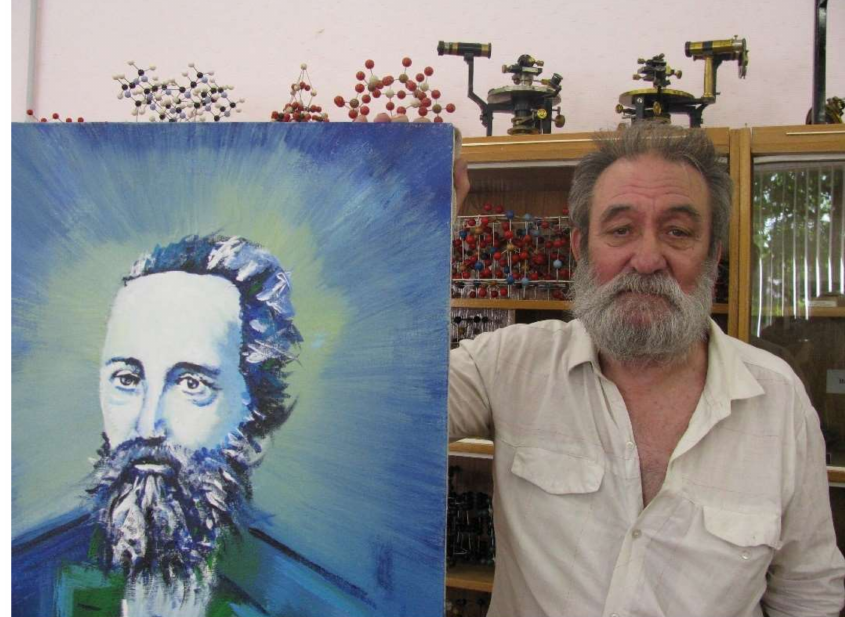
Figure 2. Vadim ˙El’eviˇc Cubin (Fedorov) ( right ), great-grandson of Evgraf Stepanoviˇc Fedorov, when he visited the Department of Crystallography of SPbGU—accompanied by his wife Ljudmila Vasil’evna—50 years after finishing his studies on the occasion of a festive session of the Department. He shows the portrait of his great-grandfather, done by the young artist Roman Kajukov—student at the Department. Middlesized, chunky and with full beard Vadim shows his resemblance to his famous ancestor (Photo by S. K.